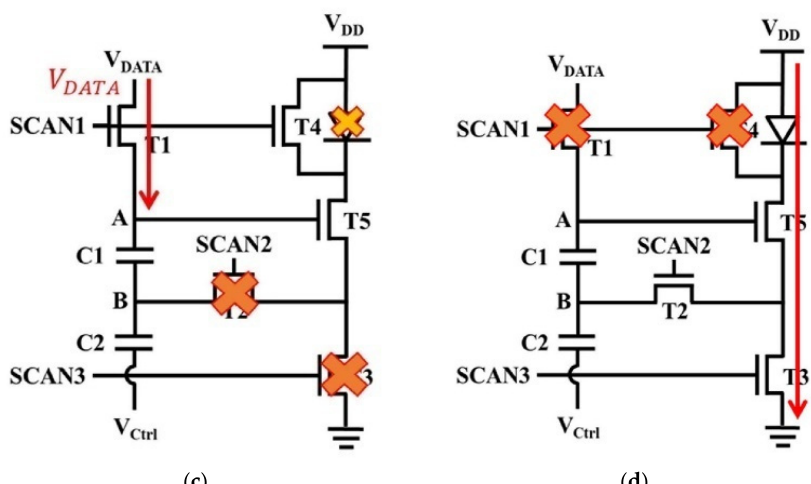
Figure 3. Schematic of circuit operation in various periods with ( a ) reset ( b ) compensation ( c ) data input ( d ) emission period.